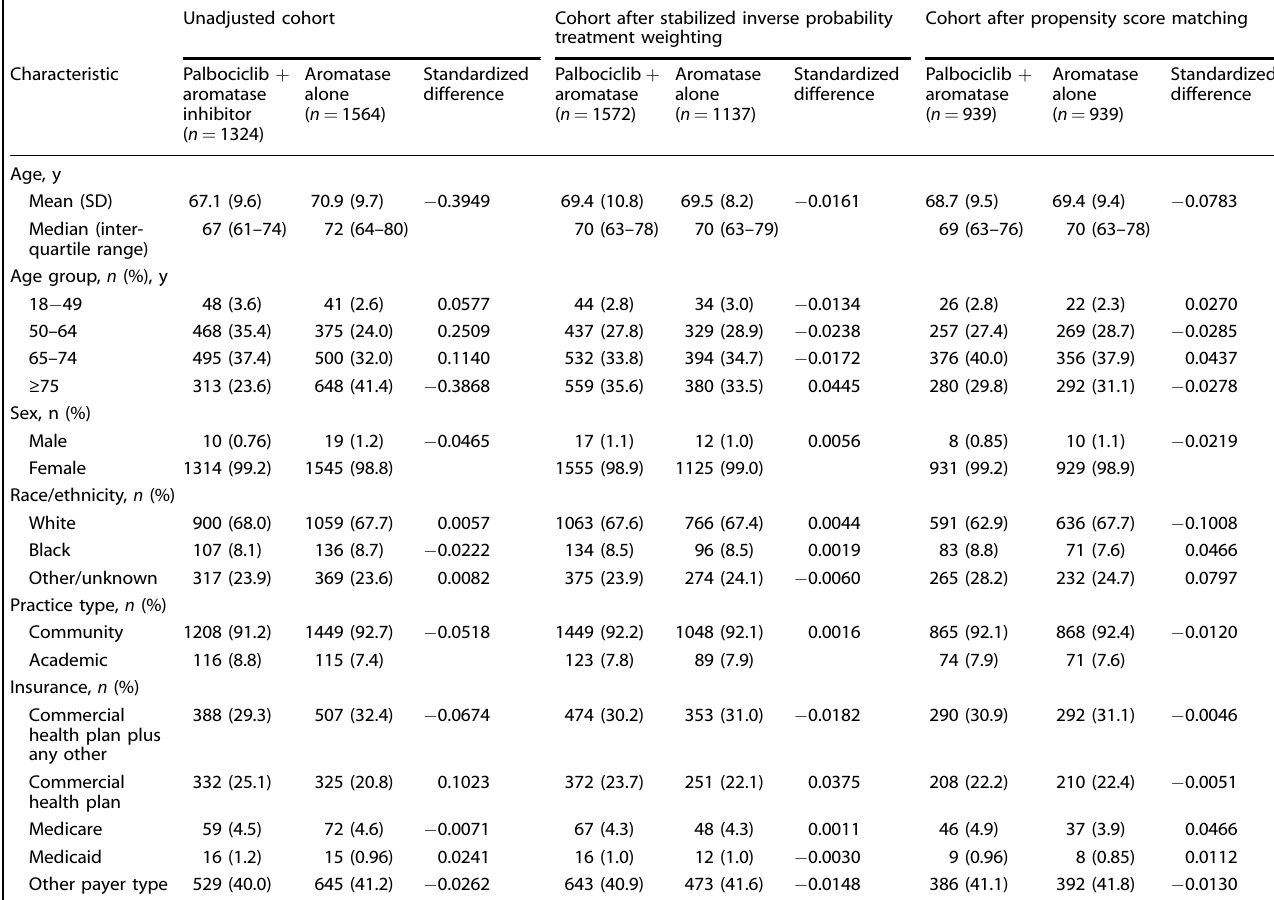
Table 1. Patient demographic